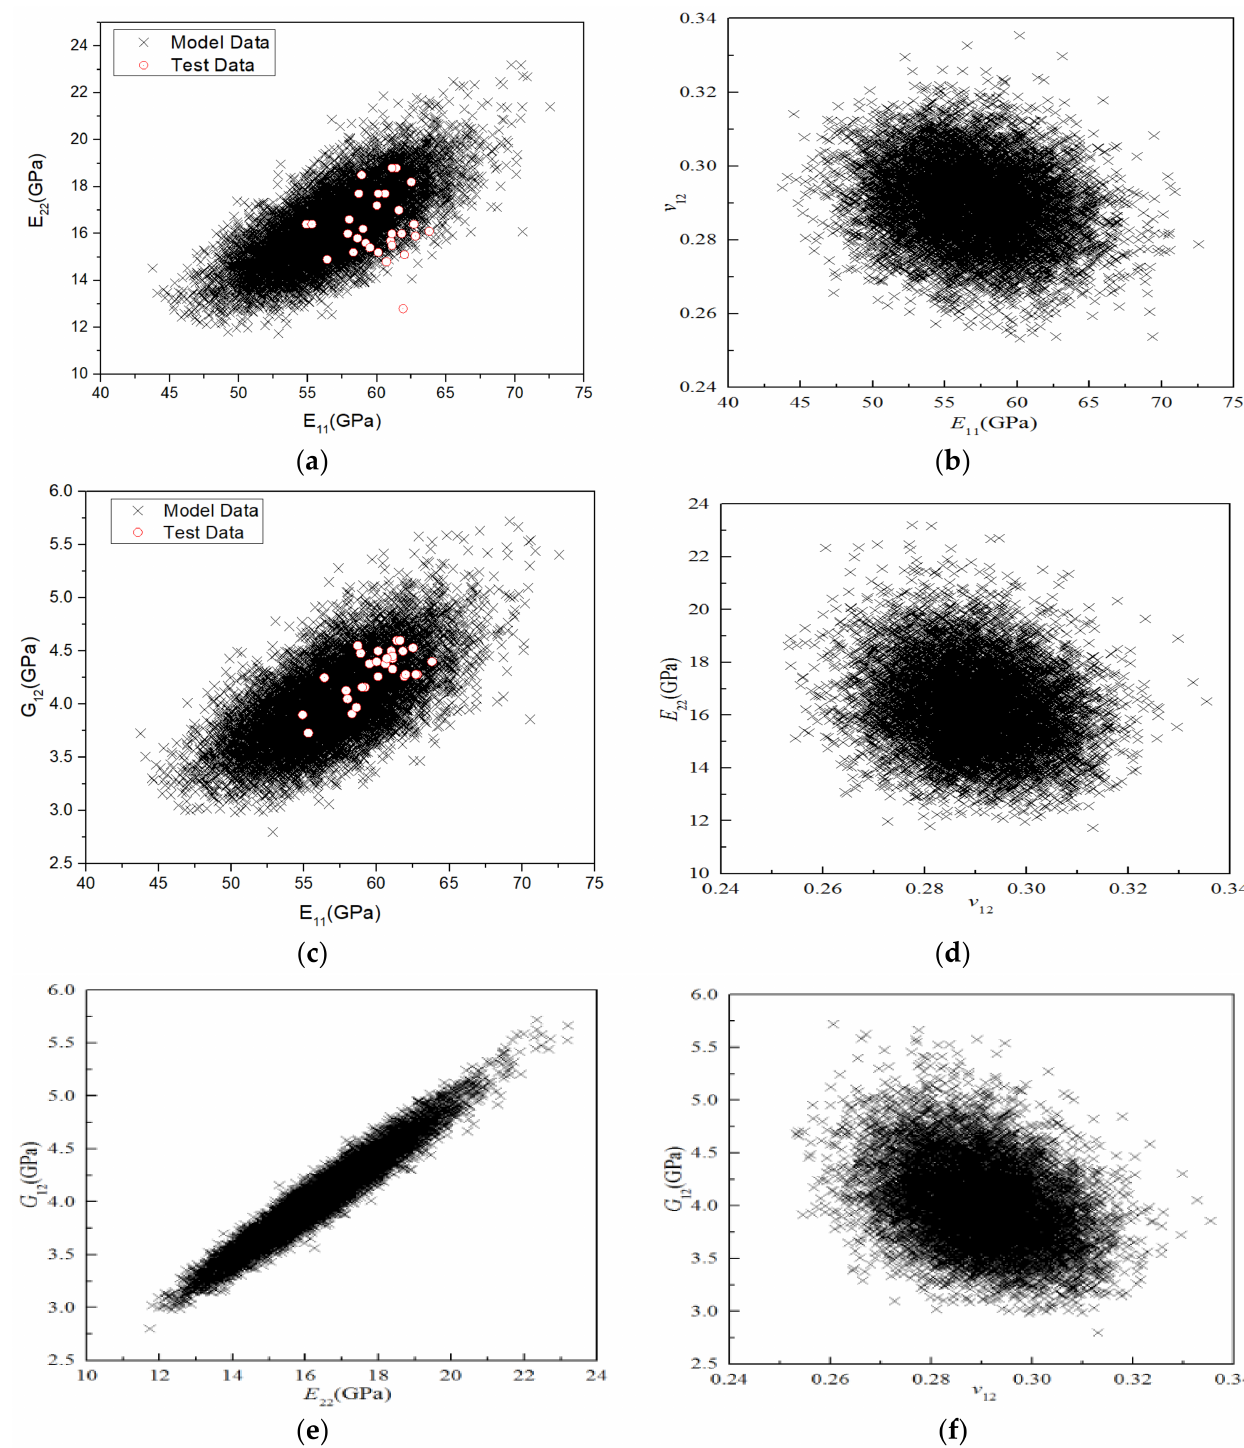
Figure 19. Correlations between the stiffness properties of H-GFRPs under the RTD condition. ( a ) E 11 and E 22 , ( b ) E 11 and v 12, ( c ) E 11 and G 12 , ( d ) E 22 and v 12, ( e ) E 22 and G 12 , ( f ) v 12 and G 12